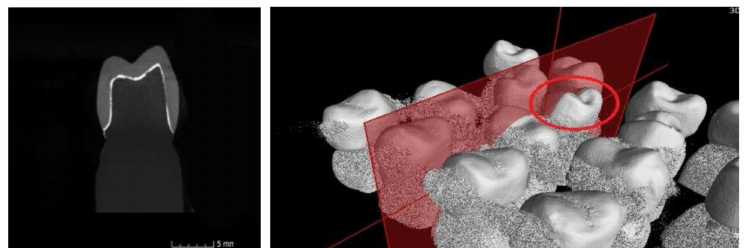
Figure 6. Images from the micro-CT program for the FM samples.